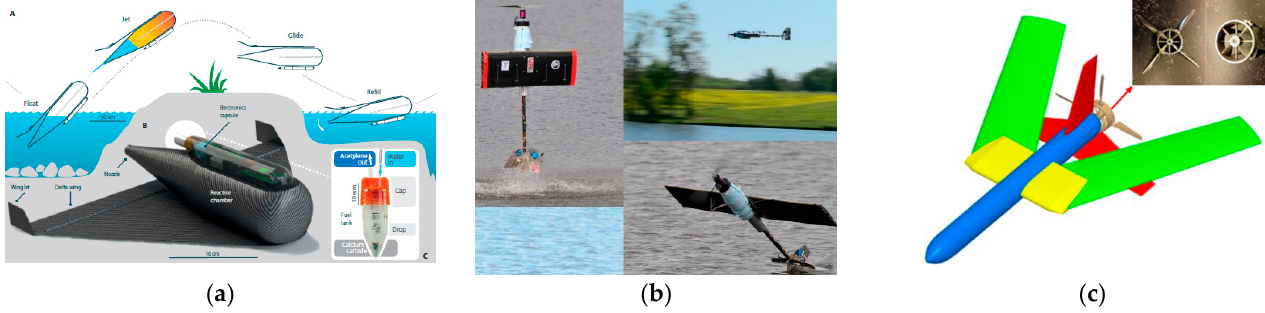
Figure 3. The morphing configuration of the HAUV. ( a ) Kovac’s team; ( b ) Stewart’s team; ( c ) Guo’s team. Compared with multi-rotor HAUVs, morphing HAUVs have the advantage of fast flight in air. However, the accommodation of the aerial and underwater movement effi- at present. Morphing HAUVs are at a very early stage where researchers are focused on the verification of the whole trans-media process with a manual remote-control mode. Nevertheless, it only achieved partial success in the whole trans-media process. At pre- sent, the vehicle is equipped with very little electronic equipment that would be suscepti- ble to impact acceleration. In future, slow, vertical landings or the application of impact load-resistant electronic equipment could be considered as a solution to the impact load problem. A jet thruster could achieve a fast incline egress, while an air propeller could only achieve a vertical egress. Jet thruster power and variable-sweep configuration seem to be promising technical solutions. In addition, multirotor HAUVs were designed and tested for multi-locomotion, ben- efiting from high maneuverability and hover capability. Neto proposed the first concept of a multirotor HAUV with four underwater propellers and four air propellers [19]. Fol- lowing this, Maia [20], Feng [21], and Alzu’Bi [2] designed and manufactured multirotor HAUVs, as presented in Figure 4. They repeatedly completed the experimental verifica- tion of the air flight, underwater navigation, and vertical water–air multi-locomotion. Maia and Feng’s HAUVs were neutrally buoyant with a dual-propeller system. A coaxial design was adopted, with Maia using eight of the same specially designed gas propellers for both air and water mediums, while Feng preferred four gas propellers and four water propellers. The dual-propeller system guaranteed seamless multi-locomotion with con- tinuous aerial and underwater power. Alexandre also proposed an HAUV with four aquatic water and four aerial gas propellers [22]. Four aerial propellers were used both in air and underwater in Alzu’Bi’s design. It floated on the surface of the water with a depth control system and then achieved flight. Furthermore, a student team proposed an am- phibious collapsible helicopter called the Waterspout [23]. It would totally depend on buoyant force, ascending from a released point underwater to the water’s surface. Lu at- tempted to develop an HAUV with four gas propellers and two fixed side wings to pro- vide the lift necessary for flight and underwater gliding. Further to this, it could achieve three modes: forward-flight mode, VTOL mode for the water–air trans-media process, and underwater-glide mode [24]. It was therefore expected that this design would have better endurance. In general, in benefiting from the hover capability, multirotor HAUVs have repeat- edly realized successful multidomain locomotion, but the probability of a successful egress is low. Successful egress requires the remote-control operators to be well experi- enced. The optimized configuration design needs to improve the disturbance-rejection ability, and the efficiency of air–underwater movement needs further research.